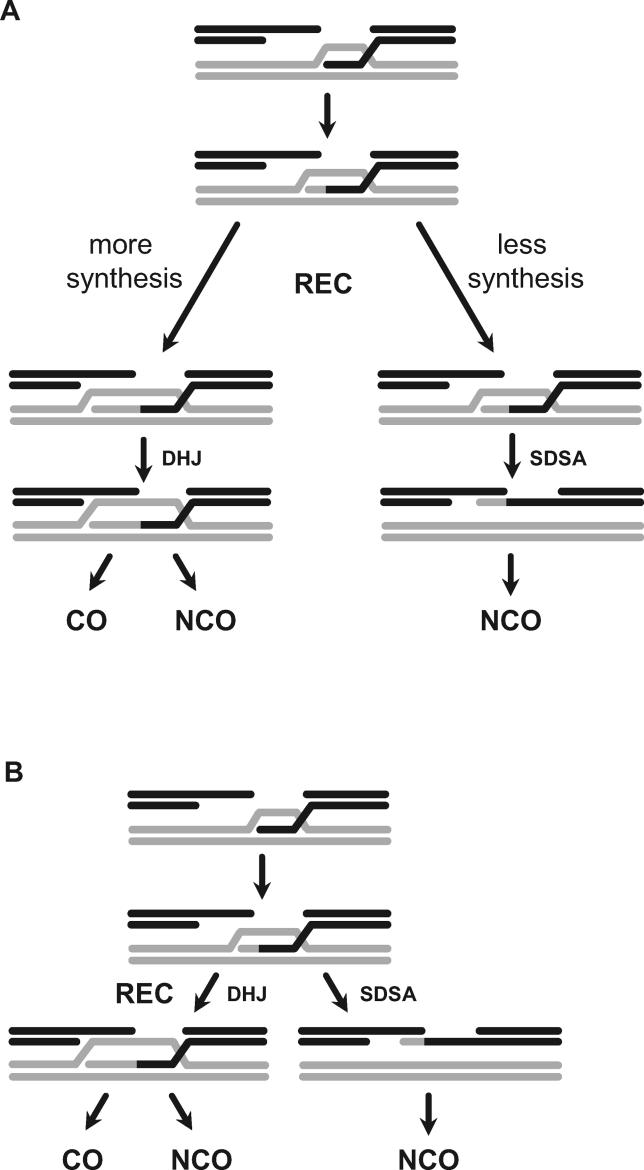
Models for REC Function in Meiotic Recombination(A) REC facilitates repair synthesis at all sites of meiotic recombination. Longer synthesis tracts allow second-end capture leading to DHJ intermediate formation, which can be resolved to generate COs and NCOs. If there is less repair synthesis, the newly synthesized strand can dissociate, anneal to the other broken end, and give rise to a NCO via SDSA.(B) REC is present only at sites that will mature into DHJ intermediates. After initial repair DNA synthesis, some single-end invasions dissociate and anneal to the broken chromosome giving rise to NCOs via SDSA. Other single-end invasion, intermediates produce more repair synthesis in a REC-dependent manner to give rise to DHJs that can be resolved to generate either a CO or a NCO.